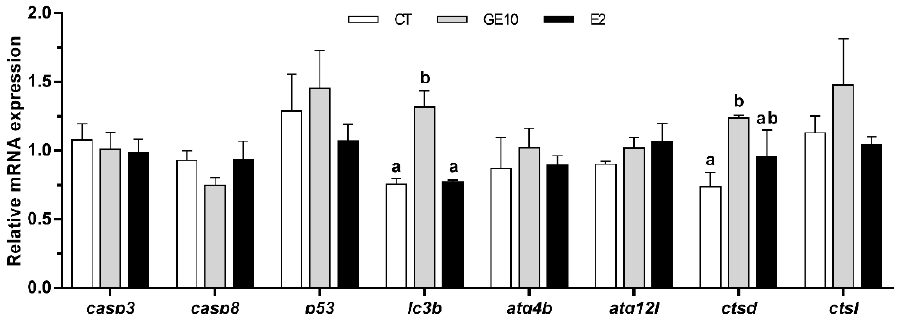
Figure 3. In vitro effects on confluent rainbow trout preadipocytes incubated at day 7 of culture for 72 h with GE (10 μM), E2 (1 μM), or vehicle (0.1% DMSO) as CT over the expression of apoptosis- and autophagy-related genes. Relative mRNA expression normalized to ef1α and β-actin of casp3 , casp8 , p53 , lc3b , atg4b , atg12l , ctsd , and ctsl . Data are shown as mean + SEM ( n = 6). Significant differences among treatments for each gene were determined by one-way ANOVA and are indicated by different letters ( p < 0.05). When two groups share at least one letter, they are not statistically different. CT: Control; GE: Genistein; E2: 17β-estradiol.